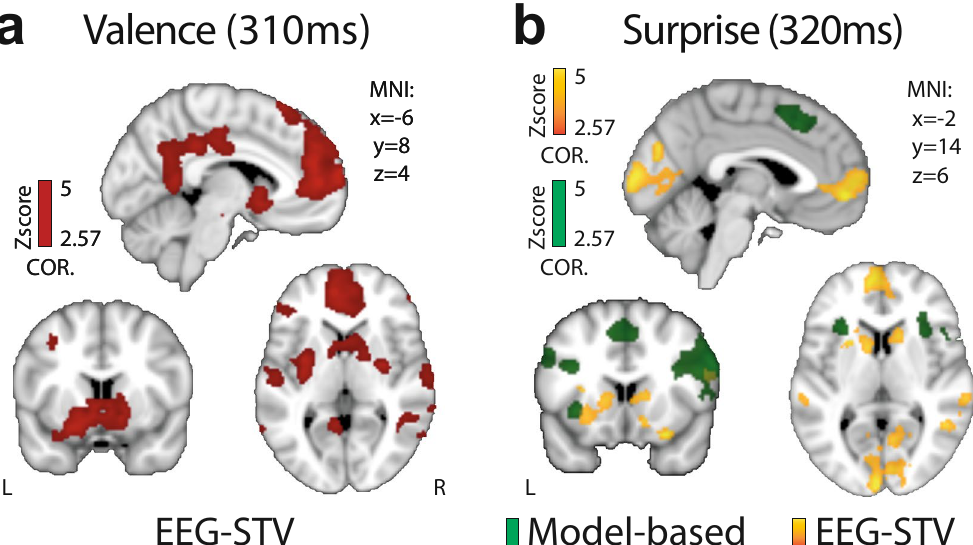
Figure 4. Spatiotemporal characterization of RPE valence and surprise signals. ( a ) Regions correlating with the EEG STV in our valence component, exhibiting overall greater response for positive compared to negative RPEs. ( b ) Regions correlating positively with outcome surprise as captured by a RL model (green) and the STV in our corresponding EEG component (yellow), respectively. Note the complementary nature of activations in the EEG STV map. All activations represent mixed-effects and are rendered on the standard MNI brain at Z > 2.57 , cluster-corrected ( P < 0.05) using a resampling procedure (minimum cluster size = 76